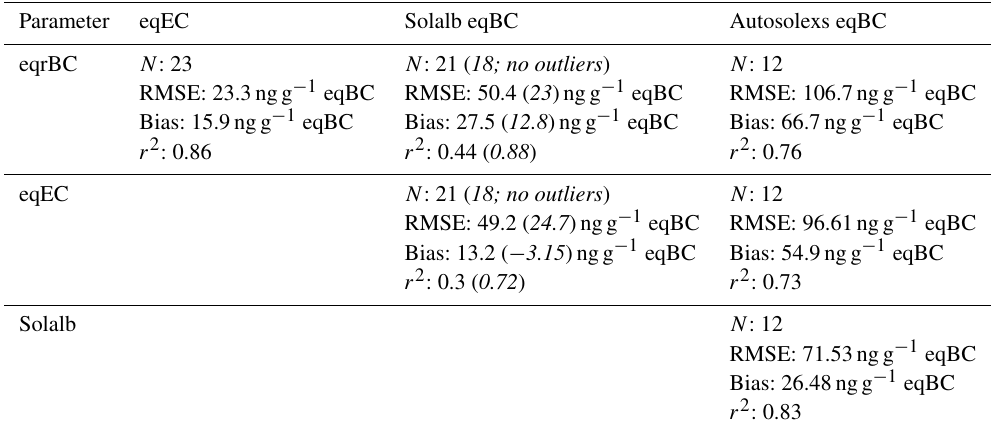
Table 1. Comparison between the different measurements of eqBC concentrations. Each cell of the table contains the number of samples ( N ) used for the statistics, the RMSE, the bias and the Pearson linear correlation coefficient ( r 2 ) between the quantities named in the first column and row. The bias is computed as a difference between the quantity named in the column header and the quantity named in the row header. The values in italic correspond to the statistics from after the removal of the three outliers of the Solalb analysis.